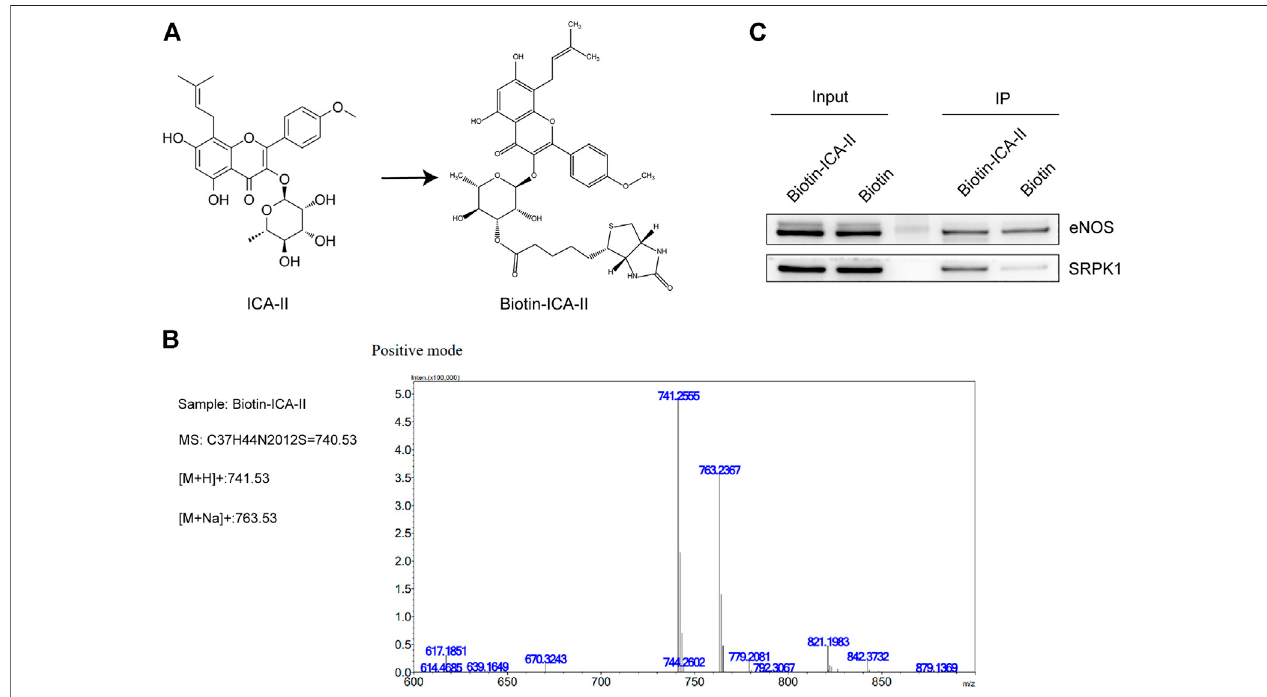
FIGURE5| ICA Ⅱ binds SRPK1 protein. (A) Chemical name and structure of ICA Ⅱ and Bio-ICA Ⅱ . (B) ESI IT-TOF MS fi ngerprint of Bio-ICA Ⅱ . (C) Lysates prepared from HUVECs were examined for ICA Ⅱ binding to SRPK1 and eNOS using pull-down assay, with biotin used as a control.